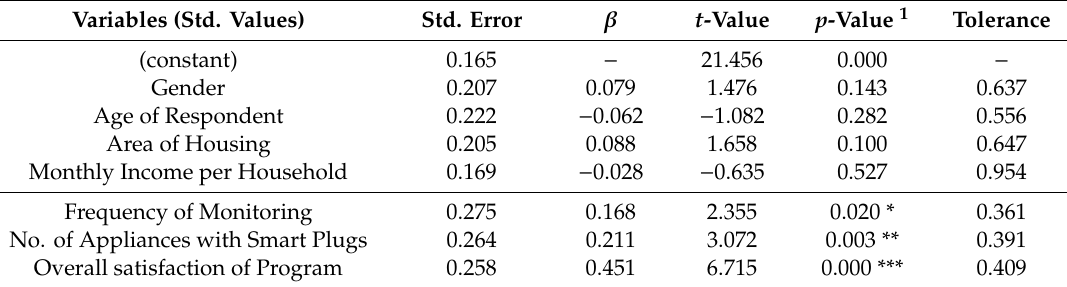
Table 6. Result of Regression Model I.